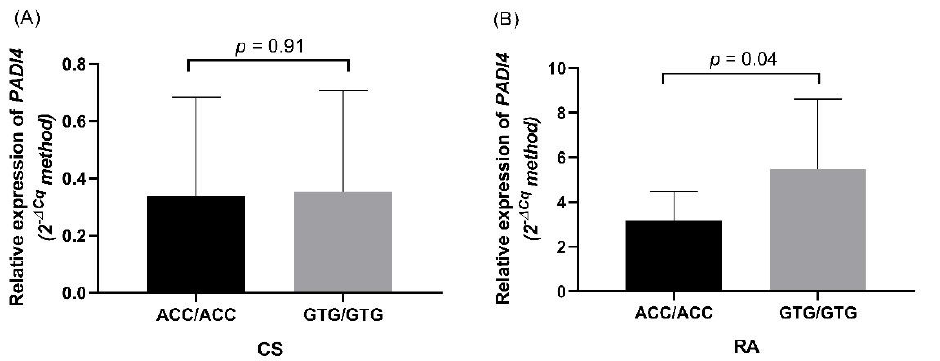
Figure 2. PADI4 mRNA expression according to the ACC and GTG haplotypes of the PADI4 gene. ( A ) PADI4 expression according to the ACC and GTG haplotypes in CS. ( B ) PADI4 expression according to the ACC and GTG haplotypes in RA. P value was calculated using the Mann – Whitney U test.